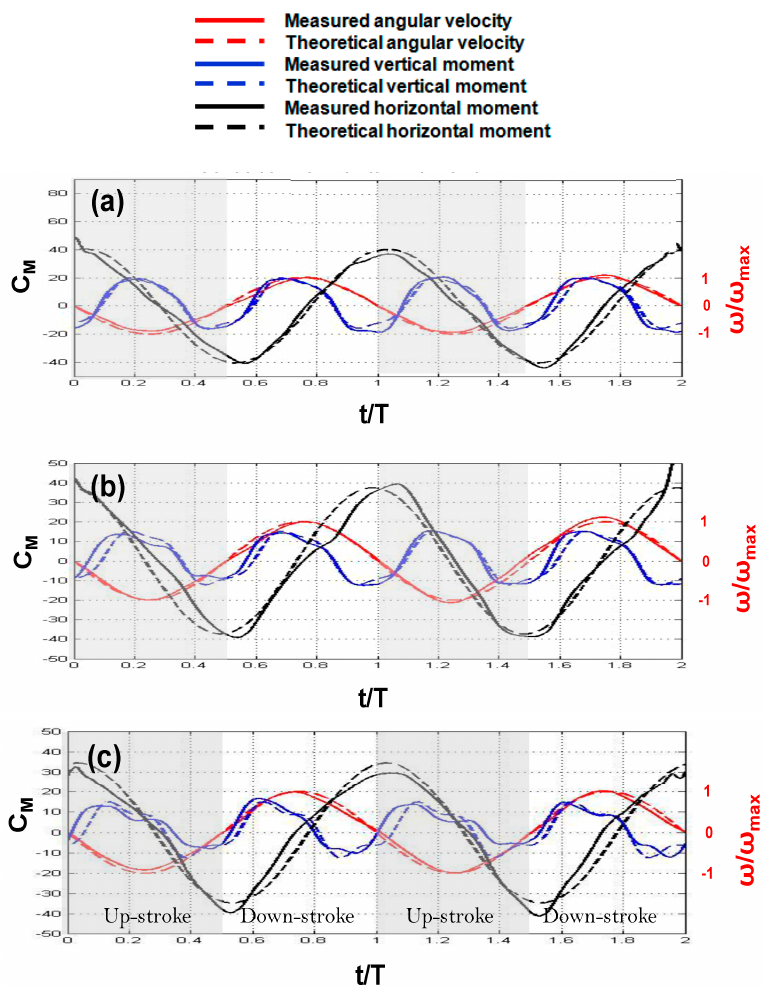
Figure 17. Non-dimensional in-plane and out-of-plane bending moments at the wing’s root vs. non-dimensional time (T is the period of flapping), at Re = 30,000 and ( a ) AOA = 5°; ( b ) AOA = 12°; ( c ) AOA = 15°.